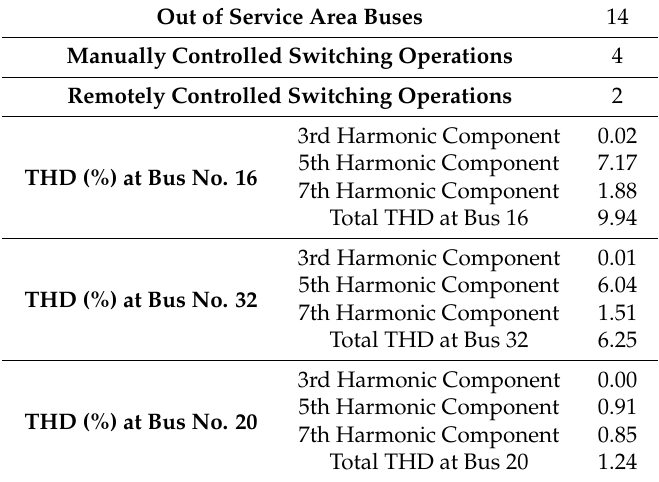
Figure 9. The harmonic components at the point of common coupling of the priority customer connected to bus no.32. THD: Total Harmonic Distortion. Table 2. Optimal values through Multi-Objective Particle Swarm Optimization (MOPSO) after restoration.